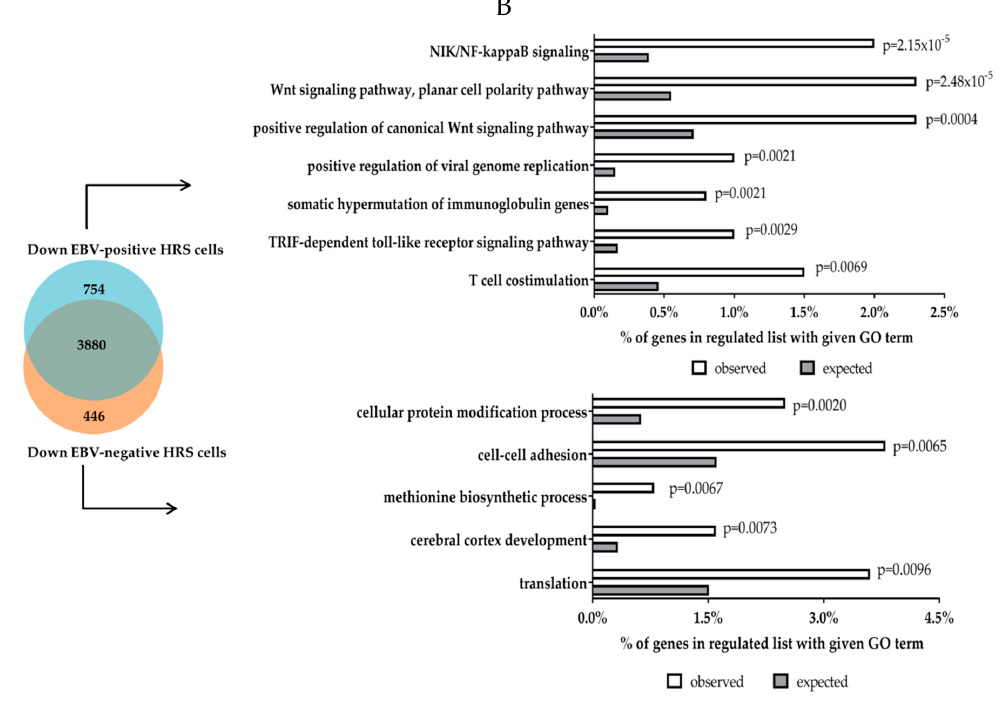
Figure 1. Gene ontology (GO) analysis of genes upregulated ( A ) and downregulated ( B ) in either EBV-positive or EBV-negative HRS cells. Gene lists were derived from our reanalysis of genes differentially expressed in either EBV-positive or EBV-negative HRS cells compared to microdissected normal GC. Gene set enrichement was performed using DAVID 6.8. (Frederick, MD, USA) [99,100]. 4. Effects of the Latent Membrane Proteins on the Phenotype of B Cells in Mouse Models